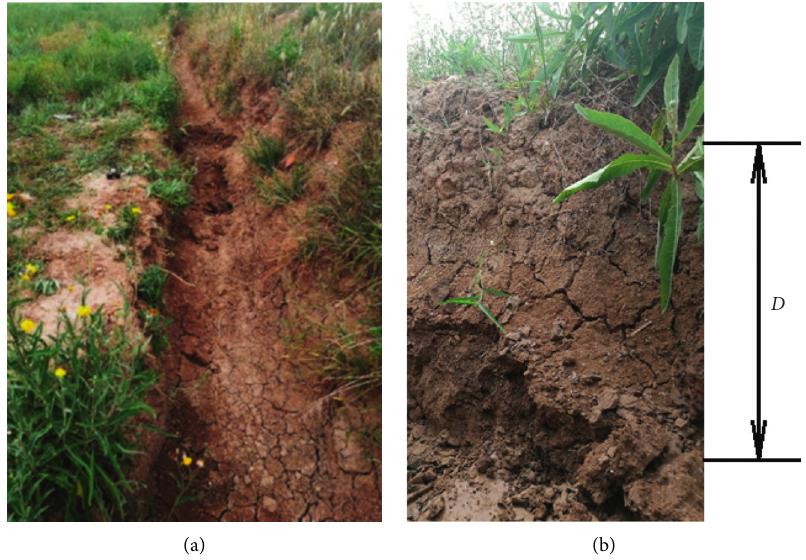
Figure 6: Open pitch used in salt-discharging field.